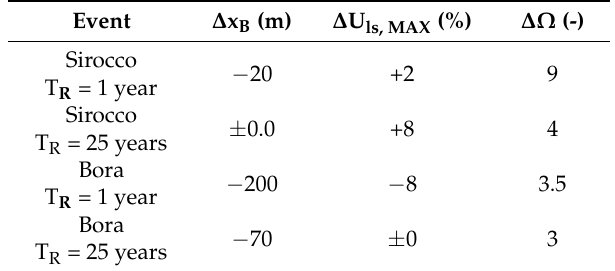
Table 3. Computed variation induced by climate changes between SCE and CTR runs of wave